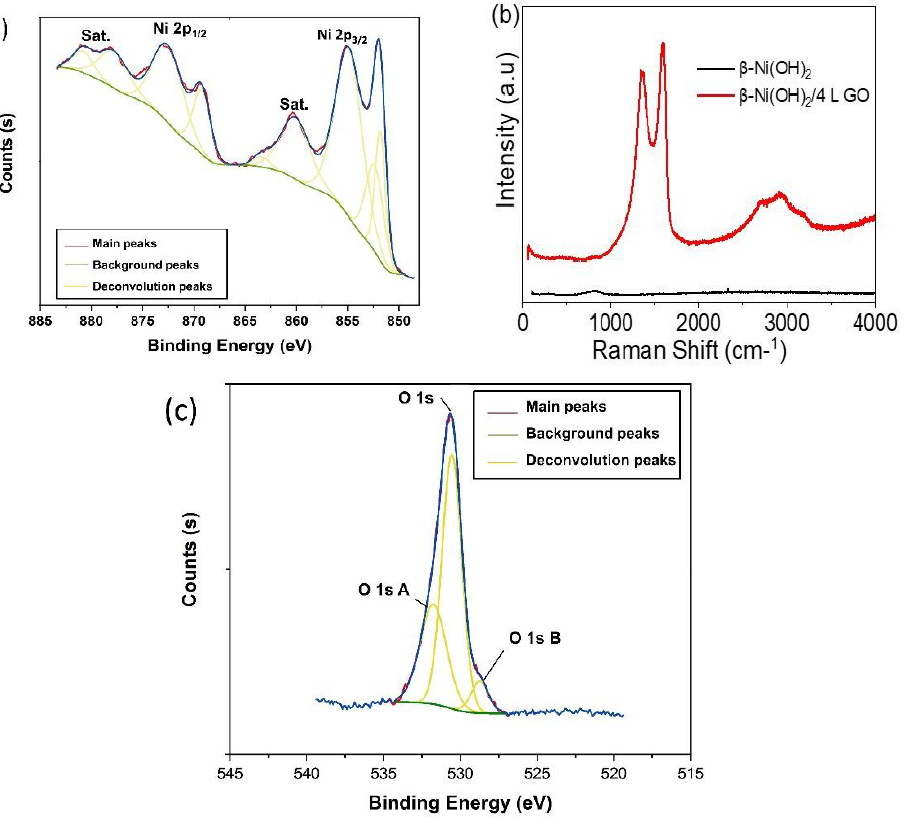
Figure 5. ( a ) XPS spectra of β - Ni(OH) 2 , ( b ) the Raman spectra for β - Ni(OH) 2 and β - Ni(OH) 2 /4L GO, and ( c ) XPS spectra of O